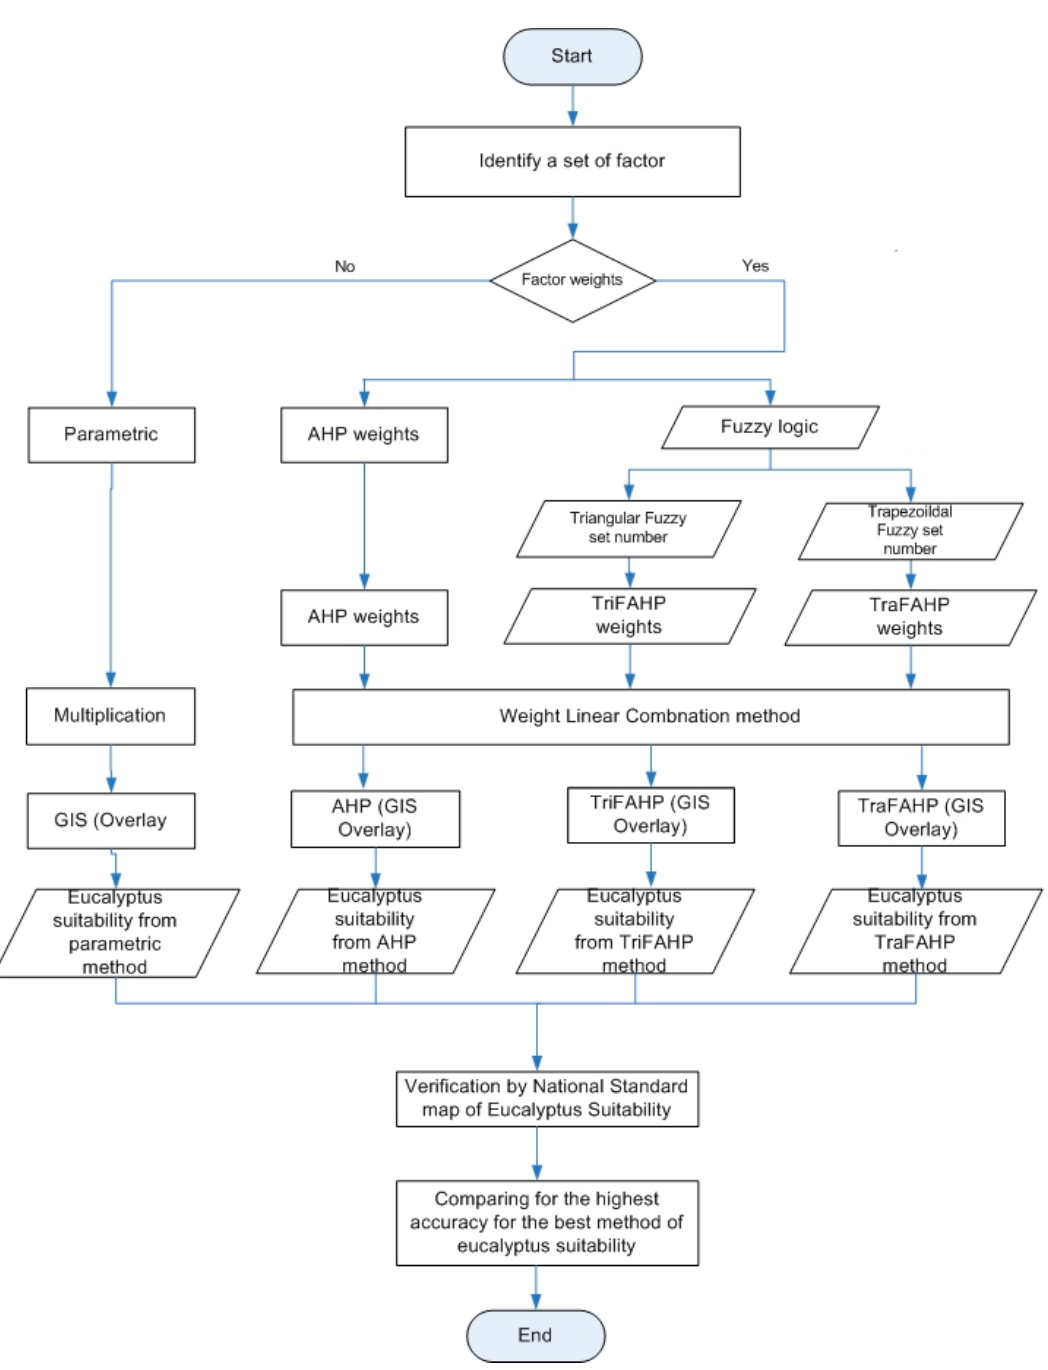
Figure 3. Methodology framework.